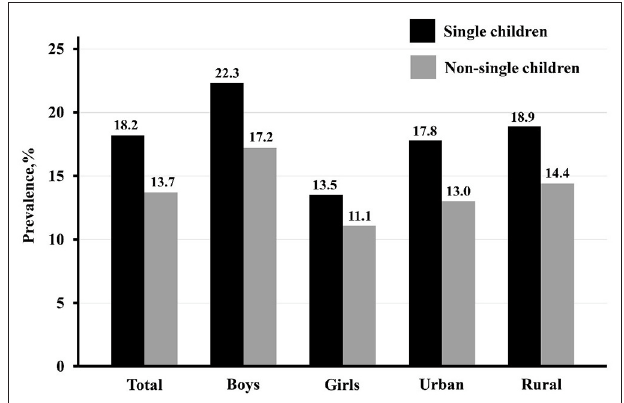
FIGURE 1 | The prevalence of abdominal obesity among single children and non-single children, stratified by sex and